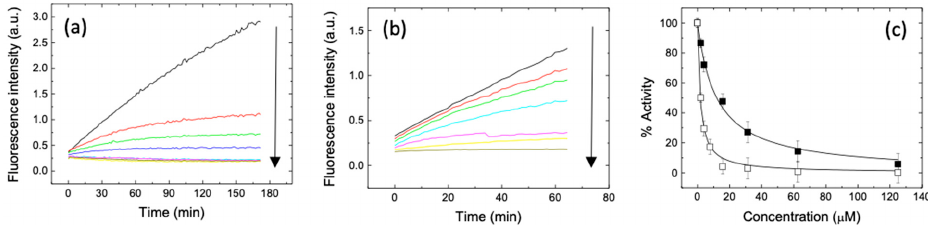
Figure 2. ( a ) Fluorescence emission of the substrate (concentration 20 μ M) in the presence of 3CLpro (0.2 μ M) as a function of time, at varying amounts (0–125 μ M) of ( a ) eugenol and ( b ) estragole. The initial slope of the curves quantifies the enzymatic protein activity. The arrows indicate the increase in inhibitor concentration. ( c ) Inhibition curve for eugenol (open squares) and estragole (closed squares). The continuous line is from a non-linear least squares regression fit, and provides the inhibition constant (K i = 0.81 and 4.1 μ M for eugenol and estragole, respectively). The different colors in (a, b ) correspond to the different concentrations shown in ( c ): 0 (black), 1.95 (red), 3.91 (green), 7.81 (blue), 15.63 (cyan), 31.25 (magenta), 62.5 (yellow), and 125 μ M (brown).